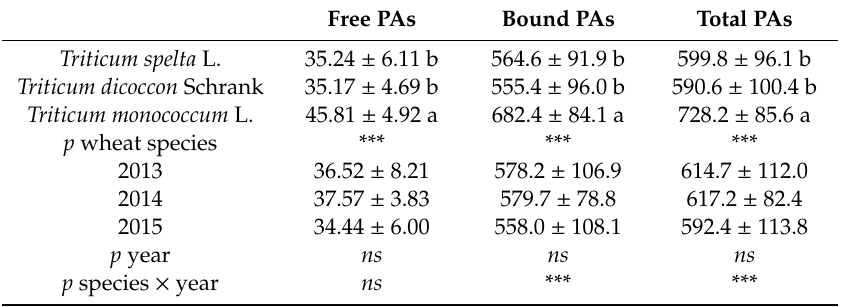
Table 2. E ff ect of wheat species and cultivation year on phenolic acids (PAs) concentration ( µ g / g dry mass) in whole grain flour. All values are means ± standard deviations for four experimental replicates. Values in rows (among species or year) followed by the same letter are not significantly di ff erent at p < 0.05. Main e ff ects and interaction F-test from two-way ANOVA at *** p < 0.001, and ns —not